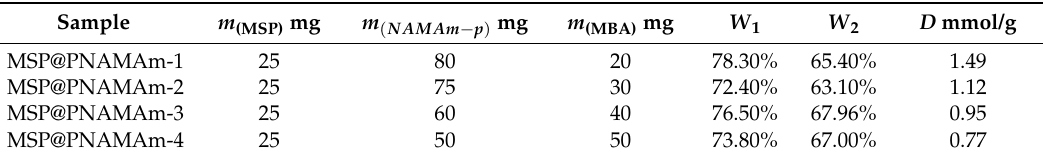
Table 1. Recipe, TGA data and the calculated alkoxyamine group density of the MSP@PNAMAm samples with different feeding amount of